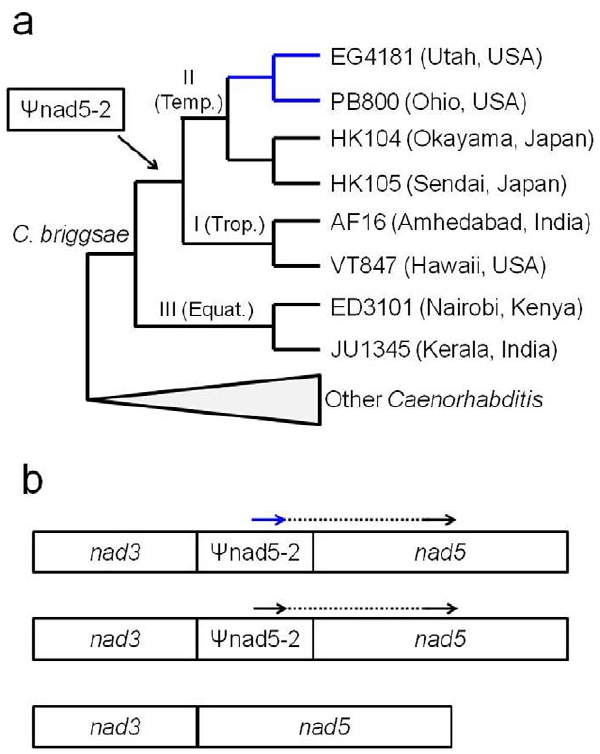
Figure 1. Phylogenetic relationships based on mtDNA of the eight C.briggsae natural strains used for MA line progenitors (a) and schematic of the nad5 D locus (b). In (a), the three major intraspecific mtDNA clades and origin of the Y nad5-2 element are indicated next to the relevant internal branches. The blue branches lead to MA line progenitors that encode the putative compensatory mutations associated with the nad5 D locus [10]. In (b), the arrows indicate positions of the 21-bp direct repeats associated with deletion formation. The dashed line indicates DNA sequences missing in canonical nad5 D molecules. The blue arrow indicates the position of the direct repeat bearing putative compensatory mutations. Clade III strains lack Y nad5-2 elements and associated deletions, as indicated in the bottom mtDNA gene model.